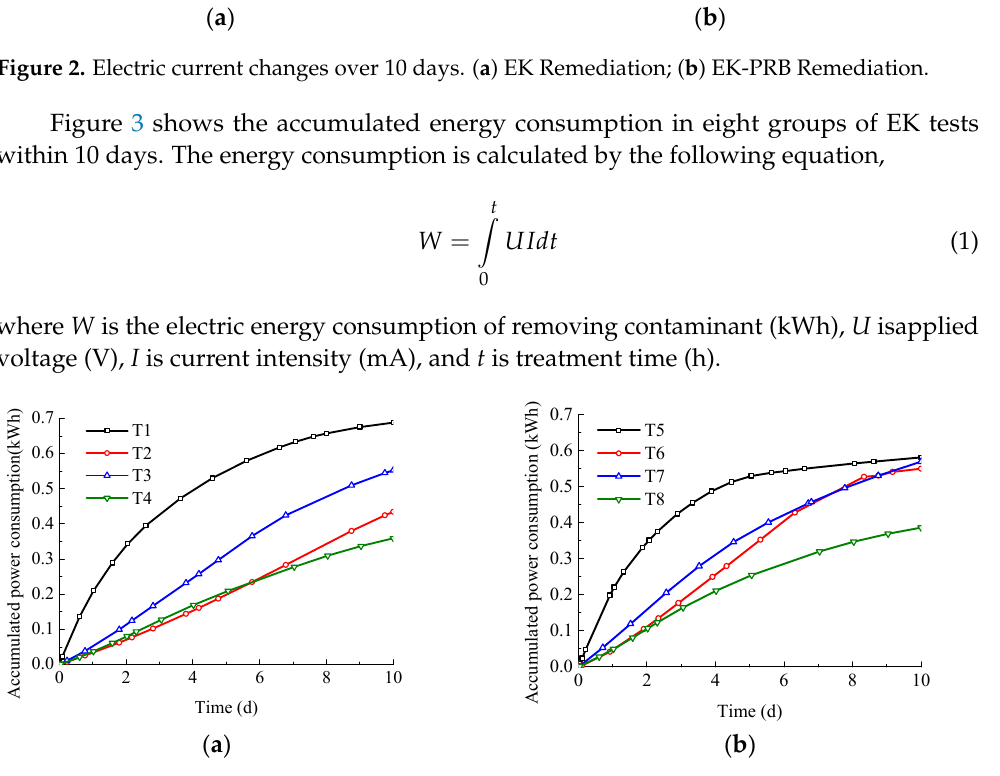
Figure 3. Accumulated energy consumption over 10 days. ( a ) EK Remediation; ( b ) EK-PRB Remediation.